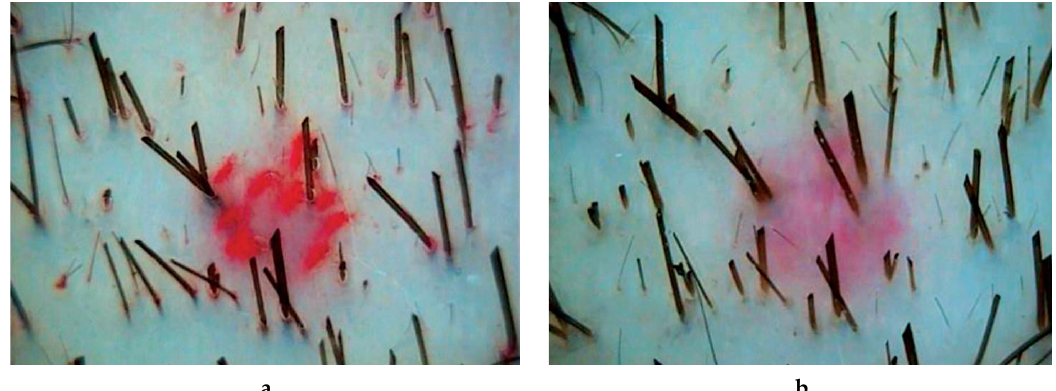
Figure 3. Trichoscopy (phototrichography) of a patient who received standard therapy with a 5% minoxidil solution: a —before treatment; b —after treatment. Magnification × 60.